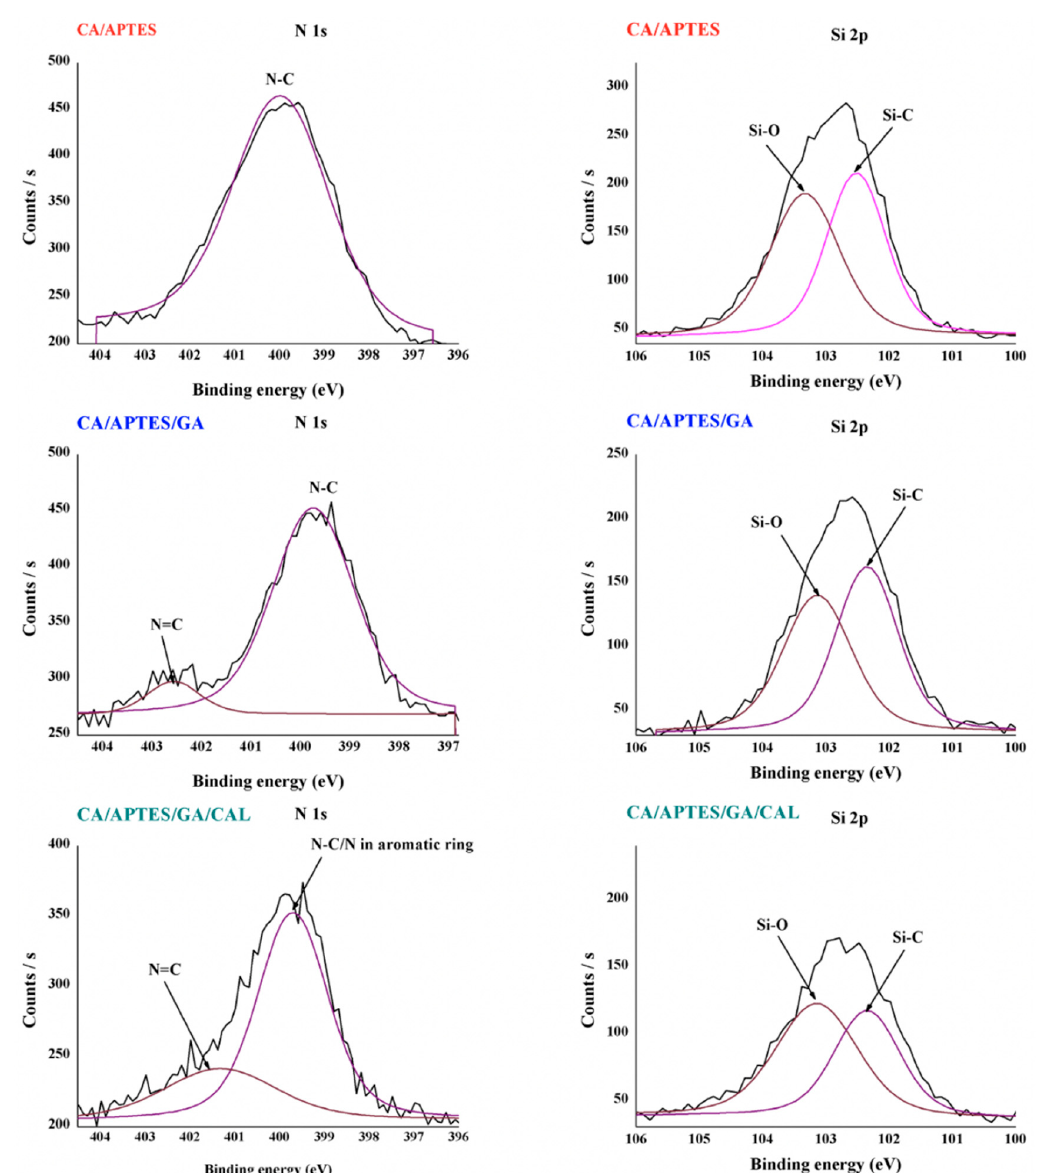
Figure 8. The fitted N 1s and Si 2p spectra for synthesized samples.